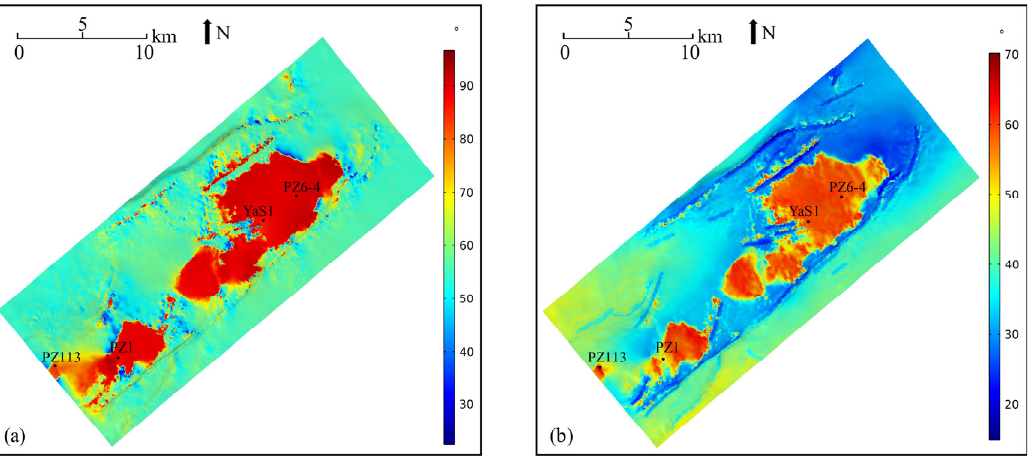
Figure 10. Distribution of the tectonic fractures in the T 2 l 4 Formation during the Himalayan period. ( a ) Prediction of the tectonic fracture strike, and ( b ) prediction of the dip angle of the tectonic fracture.